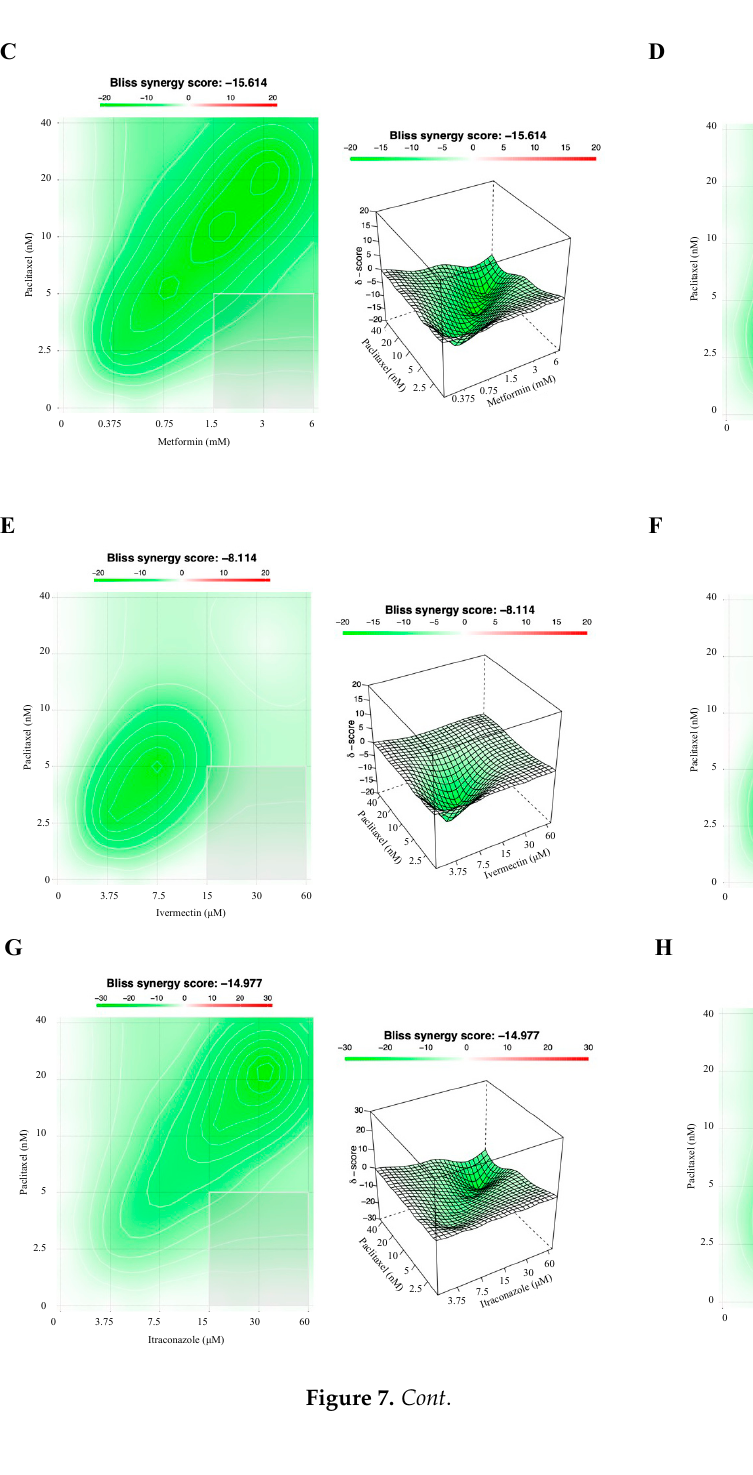
Figure 7. Combining Paclitaxel with repurposed drugs has an antagonistic effect on HOSE6.3 cells. ( A – J ) Bliss Independence and High Single Agent synergy 2D and 3D plots showing drug synergism of HOSE6.3 cells, after exposure to a fixed ‐ dose ratio that corresponds to 0.25, 0.5, 1, 2 and 4 times the individual IC 50 values each drug, e.g., Paclitaxel combined with ( A , B ) Pitavastatin, ( C , D ) Metformin, ( E , F ) Ivermectin, ( G , H ) Itraconazole and ( I , J ) Alendronate for 48 h. The combined treatment was co ‐ administered at the same time. All assays were performed in triplicate in at least three independent experiments. Synergy score: <10 (antagonism, green), =1 (additivity, white) and >10 (synergism, red). 4. Discussion Monotherapy systems have proven to be inadequate for the treatment of chemoresistant HGSC patients. Combining two or more antineoplastic drugs is a more suitable strategy that has been demonstrating an enhanced treatment efficacy [22,55] and a synergistic result in tumor growth inhibition [56]. The goal of combining drugs is to obtain maximum efficacy using a lower drug concentration to achieve a therapeutical effect with the lowest amount of toxicity and side effects for normal cells [57]. Combinatory regiments usually include a sensitizing agent and another that take advantage of the vulnerable state and increase its cytotoxic effect [22,53]. In advanced HGSC, combinatory regimens are widely used, being the concomitant administration of Carboplatin and Paclitaxel the backbone for initial treatments [58–60]. The mechanisms of action of these drugs are different, enhancing the cytotoxic effect when combined [61]. Carboplatin is an alkylating agent that binds to DNA, forming reactive platinum complexes and causing DNA cross ‐ linking, which results in modifying DNA structures and inhibits DNA synthesis. Thereby, protein synthesis and cell proliferation are blocked [62,63]. Paclitaxel is an alkylating agent that targets β‐ tubulin, a protein responsible for stabilizing the microtubule polymers, blocking cells in phases G0/G1 and G2/M leading